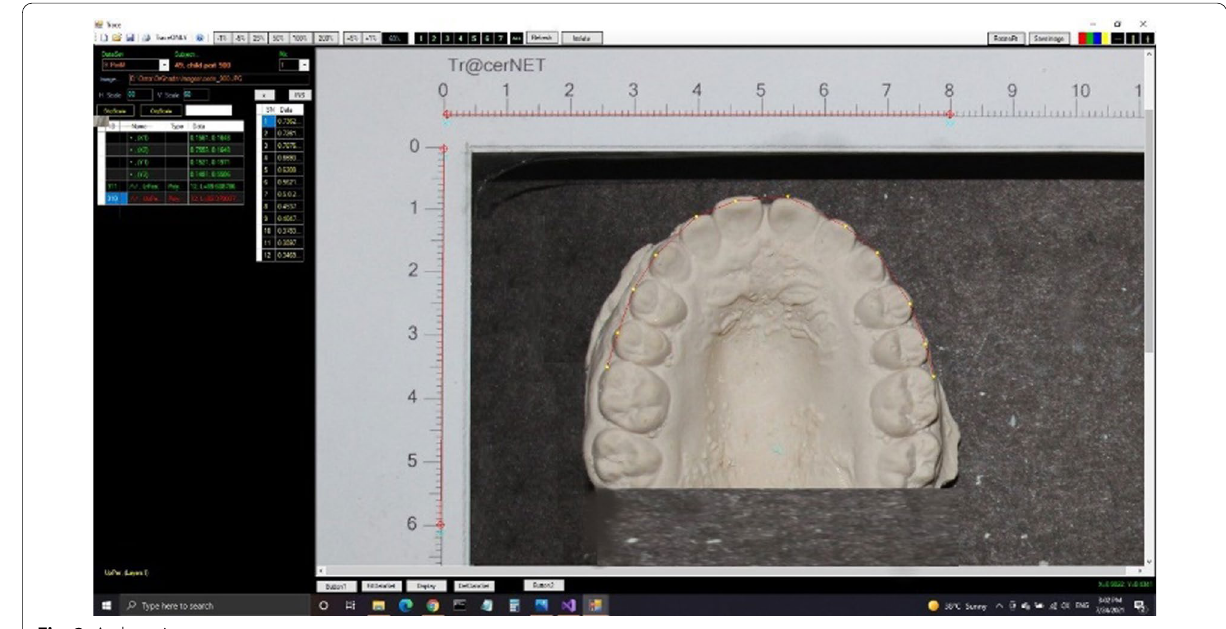
Fig. 2 Arch perimeter measurement